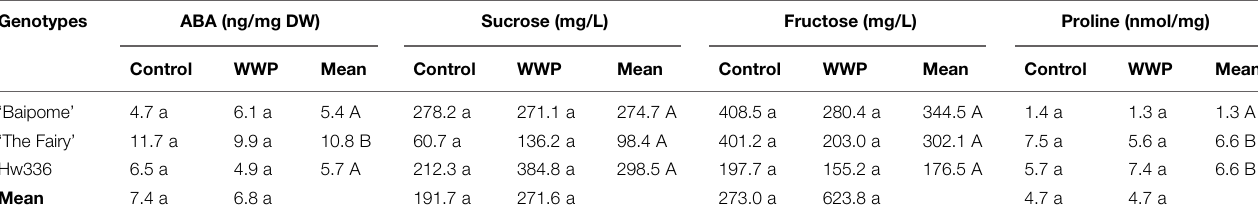
TABLE 4 | Abscisic acid (ABA), sucrose, fructose, and proline mean contents of three genotypes (‘Baipome,’ ‘The Fairy,’ and Hw336) determined in control plants and treated-plants during well-watered periods (WWPs).